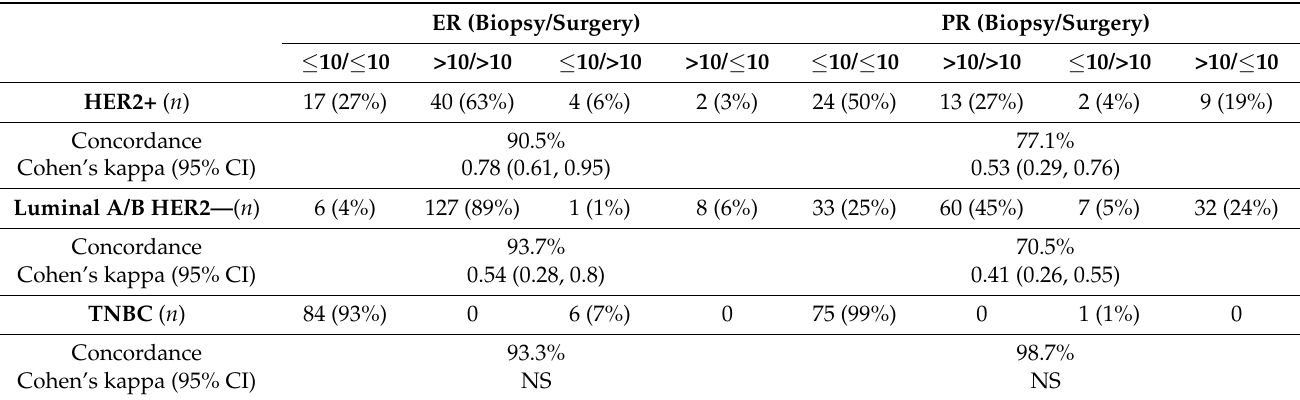
Table 3. Change in steroid receptor status between biopsy and surgical specimens and concordance analysis for all subtypes.